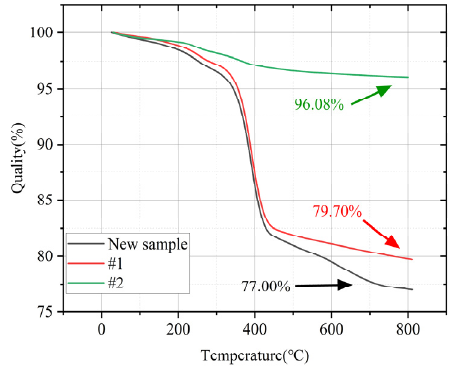
Figure 8. TGA curve of #1, #2.